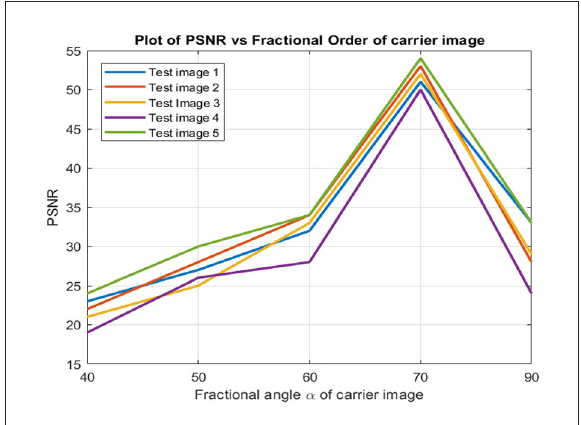
FIGURE13 PSNR results of images with different fractional order α